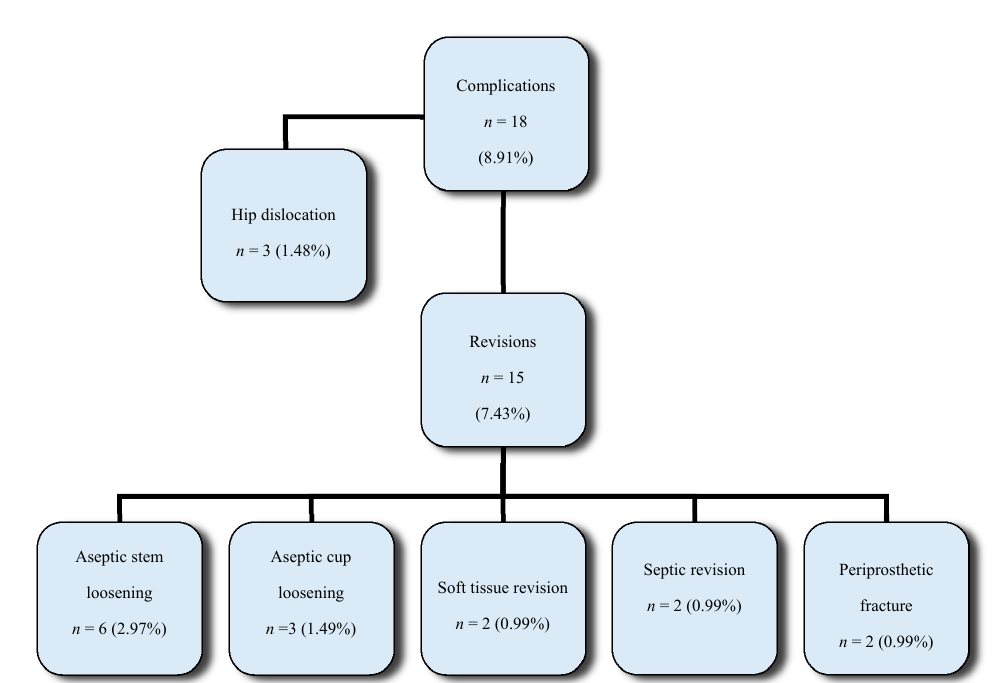
Figure 3. Complications and their required revisions in the follow-up period.